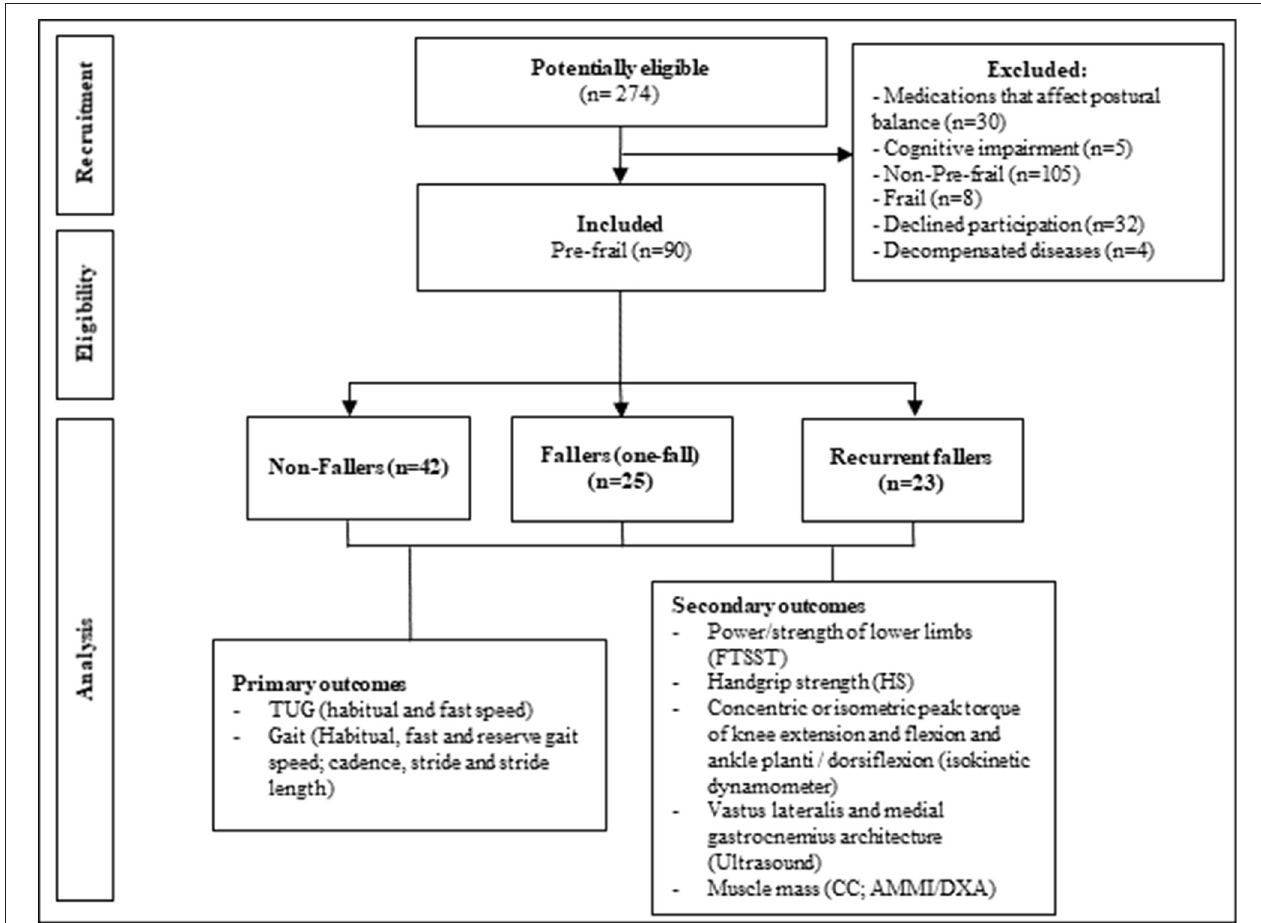
FIGURE 1 | Study flow chart. FTSST, five times sit-to-stand test; HS, handgrip strength; Cc, calf circumference; AMMI, appendicular muscle mass index; DXA, dual-energy X-ray